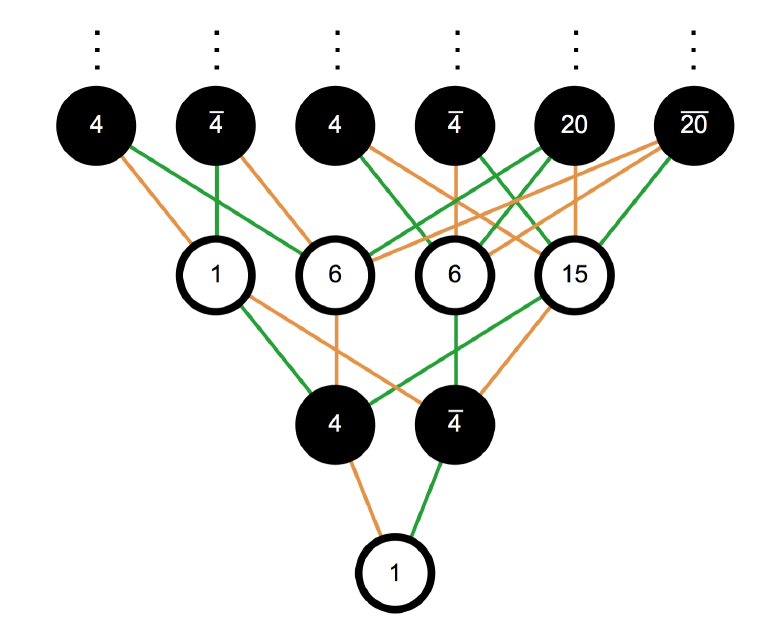
Figure 12 . Adinkra Diagram for 6D minimal scalar